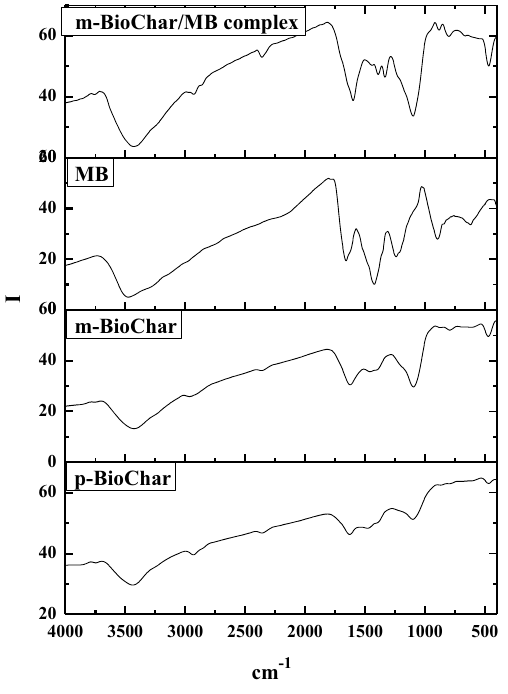
Fig. 3 FTIR spectrum of p-Biochar, m-Biochar, MB dye, and m-Bio- char–MB dye complex